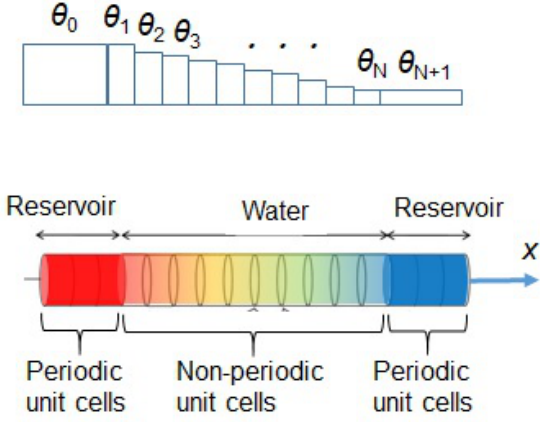
= θ − = · · · = θ = θ = · · · = θ N L + 2 N + 2 N + N R 0 and θ N + 1 L + 1